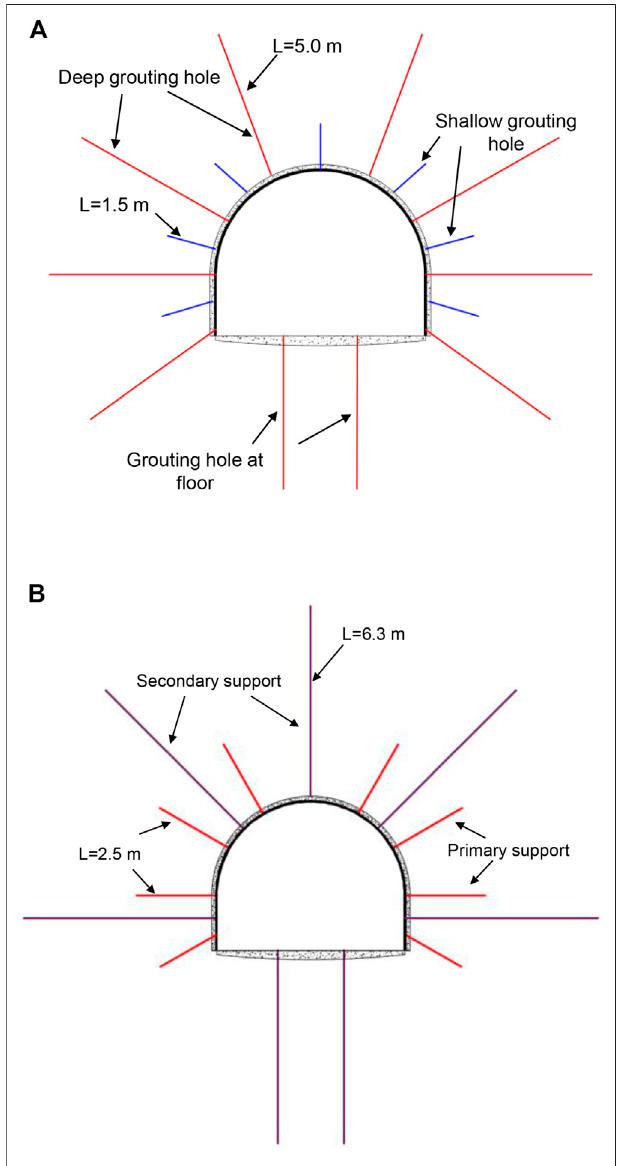
FIGURE 10 | The schematic diagram for SCCM technique. (A) Distribution of grouting holes. (B) Distribution of bolts and